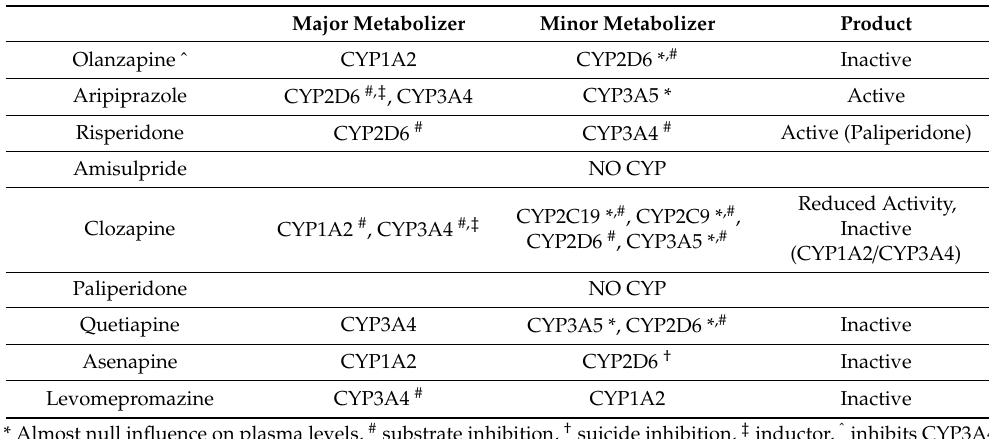
Table 7. Antipsychotic therapy CYP450-mediated metabolism.